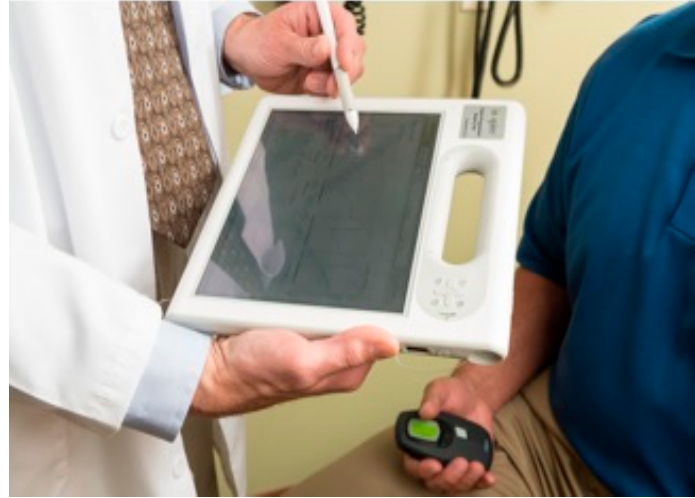
Figure 8. The Inspire programmer.